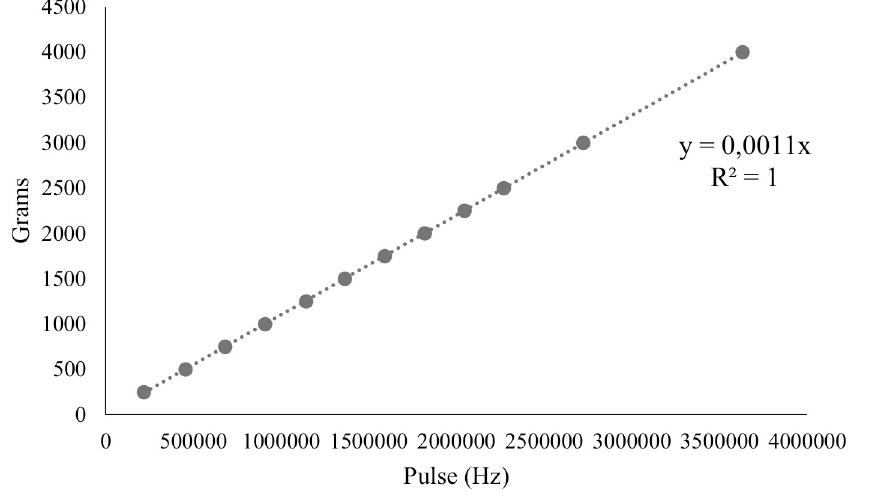
Fig 3. Calibration curve for balance one, two and